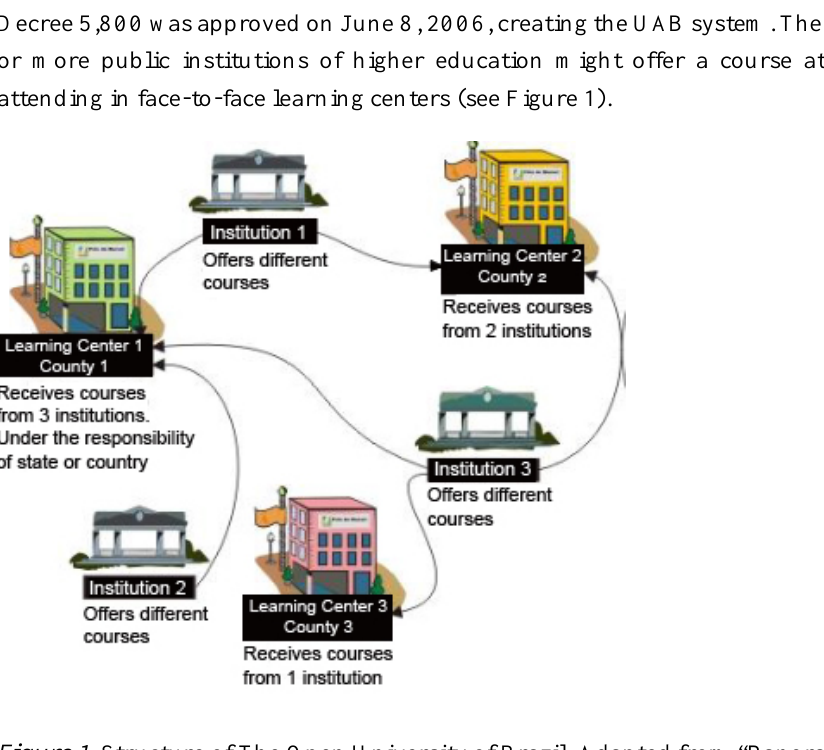
Figure 1. Structure of The Open University of Brazil. Adapted from “Panorama geral da Universidade Aberta do Brasil,” by C. J. Costa,